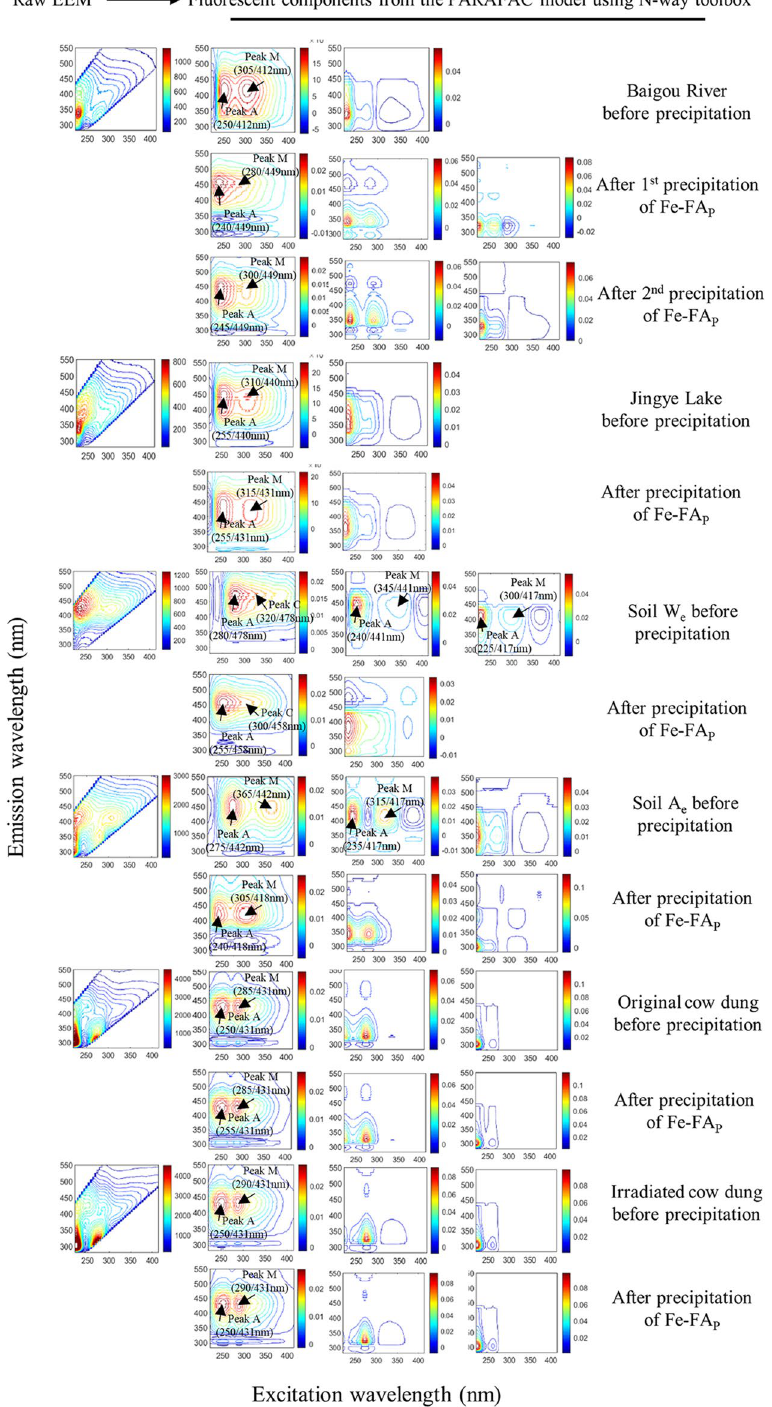
Figure 1. Original EEM spectra (left) and their fluorescent components identified by the EEM-PARAFAC model (right) of all individual aqueous samples from Baigou River, Jingye Lake, soil W e , soil A e , original cow dung and irradiated cow dung, and their remaining solutions (RS) after each repeated precipitation of Fe-FA P .. Two precipitations were performed for the Baigou River sample and one for all other